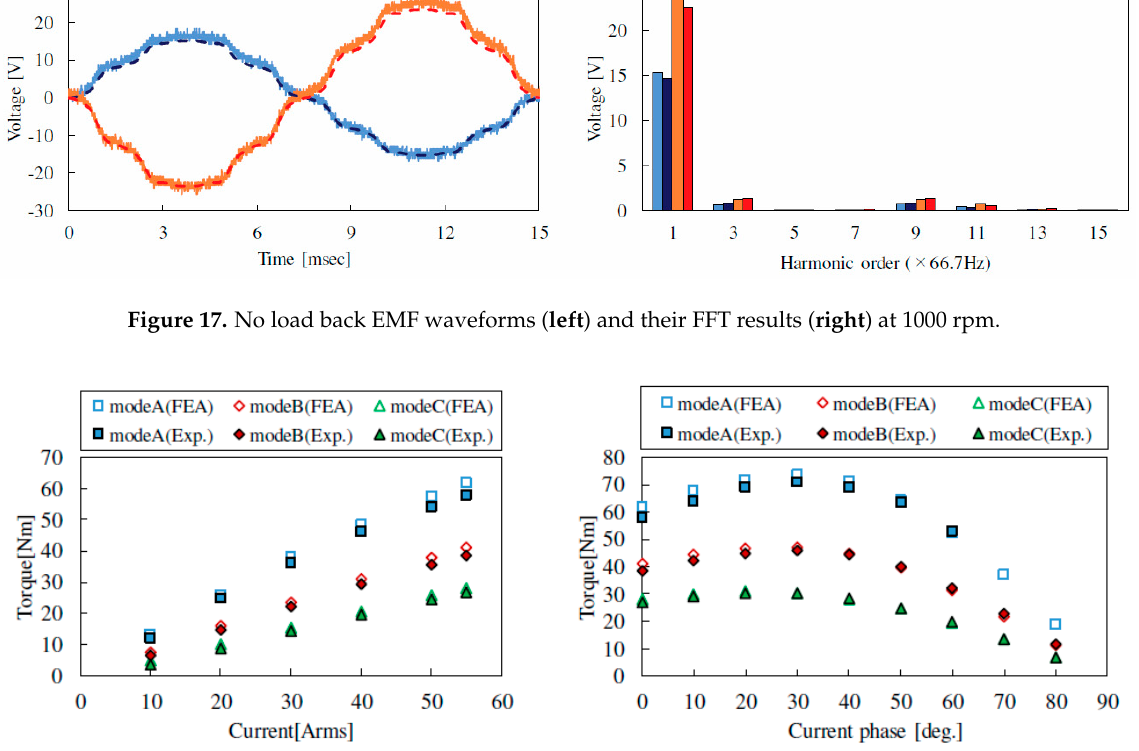
( d ) Figure 19. Experimental results of winding changing. Current waveform in each winding and torque waveform are shown. The current amplitude of each winding is calculated, the output torque is not to be changed. ( a ) Current waveform of each winding. The mode is changed from mode A to mode B. ( b ) Output torque waveform of each mode. The mode is changed from mode A to mode B. ( c ) Current waveform of each winding. The mode is changed from mode B to mode C. ( d ) Output torque waveform of each mode. The mode is changed from mode B to mode C. Figure 20 shows 3rd harmonics current control results and Figure 21 shows the out- put torque amplitude by changing the 3rd harmonics current phase. The current control shown in Figure 11 is satisfied, however, the output torque is not much increased com- pared with its FEA result even the change with the current phase is the same phenomenon because the 3rd magnetic flux is not large in the real machine.